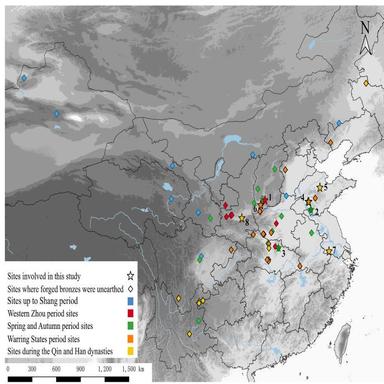
The location of sites where samples studied here are from (1. Dahekou, 2. Dahan, 3. Zaoshulin, 4. Laonongyeju and Wangfutai, 5. Xiangjianan and Shigu, 6. Qiujiazhuang, 7. Qinglongtou, 8. Changminlu and Shilipu).